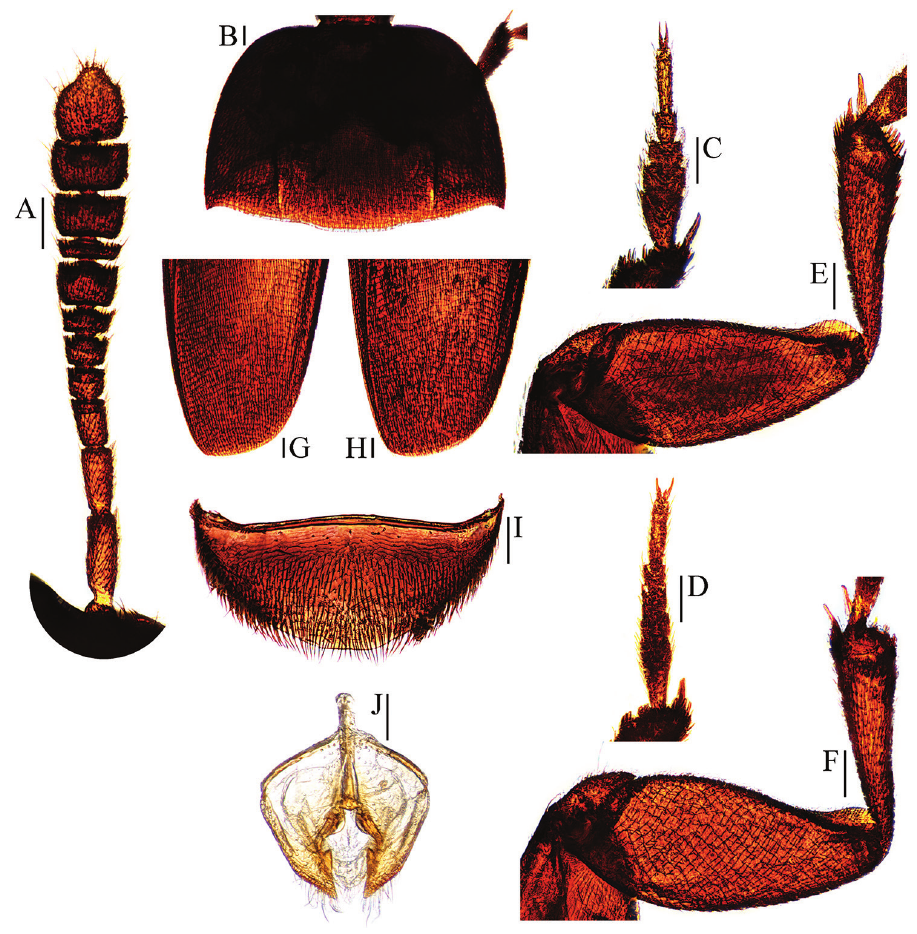
Figure 6. Ptomaphagus (s. str.) funiu sp. n. ( ♂ : paratype; ♀ : paratype). A antenna ♂ (dorsal view) B pro- notum ♂ (dorsal view) C protarsus ♂ (dorsal view) D protarsus ♀ (dorsal view) E protibia and profemur ♂ (ventral view) F protibia and profemur ♀ (ventral view) G elytral apex ♂ (dorsoapical view) H elytral apex ♀ (dorsoapical view) I ventrite VIII ♂ (ventral view) J genital segment ♂ (ventral view). Scale bars: 0.1